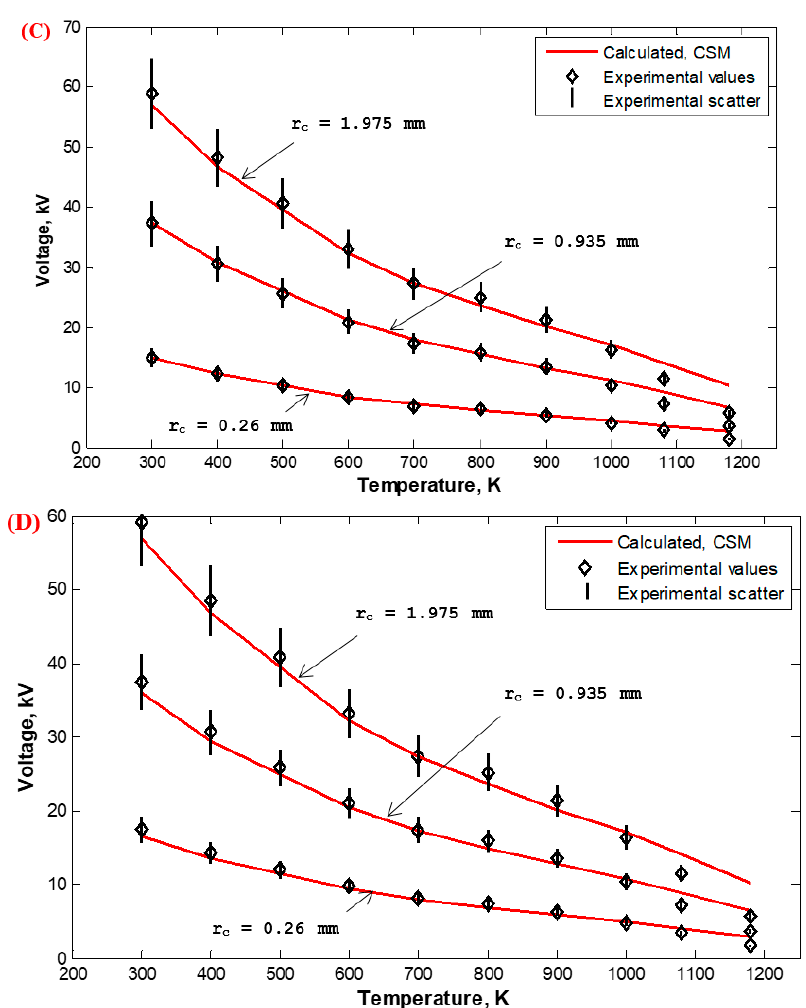
Figure 22. The corona-onset voltage of WDESP with high-temperature incoming gases: ( A ) single-wire, ( B ) multi-discharge wire (three-wire), ( C ) multi-discharge wire (five-wire), and ( D ) multi-discharge wire (seven-wire).